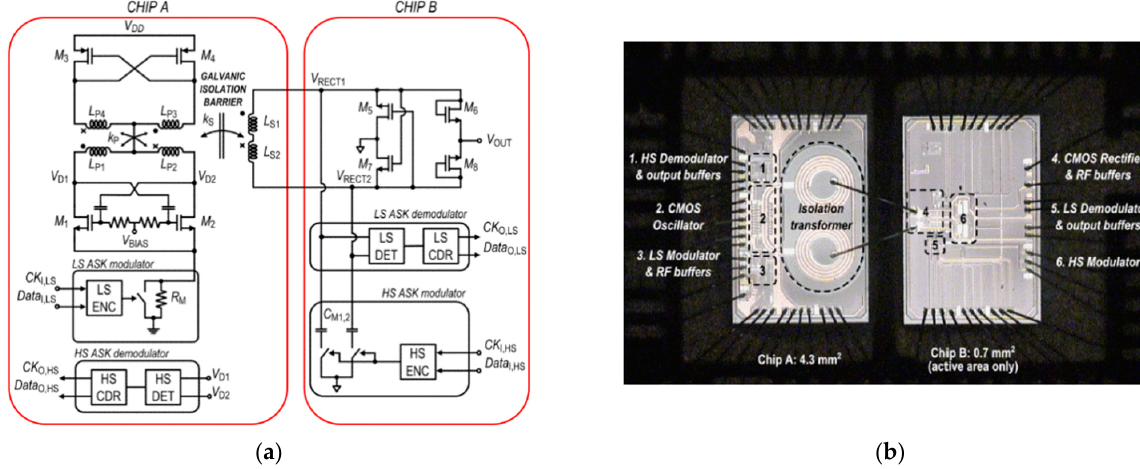
Figure 10. Single-transformer DC–DC converter with bidirectional data communication ( a ) Block diagram. ( b ) Micrograph. Reproduced from [21]. Copyright 2016, IEEE.